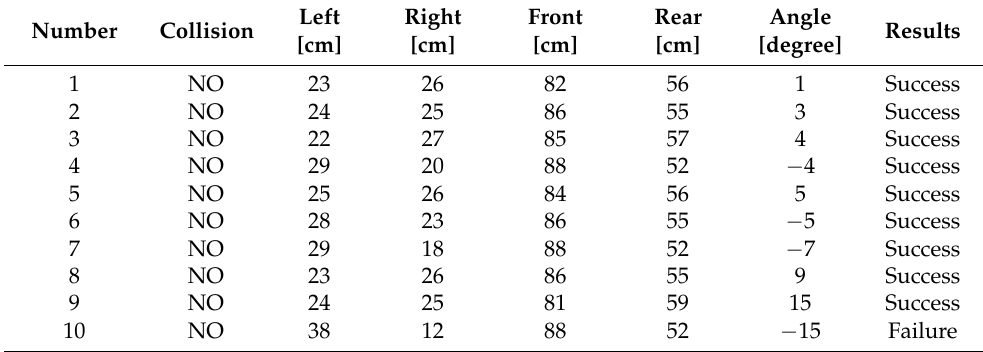
Table 6. Parking results under nonparallel initial state and unequal radii conditions. Number Collision